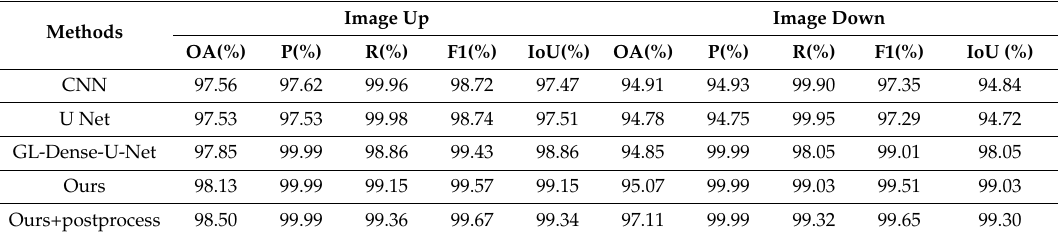
Table 5. Comparison of the results in Figure 8 with different methods.